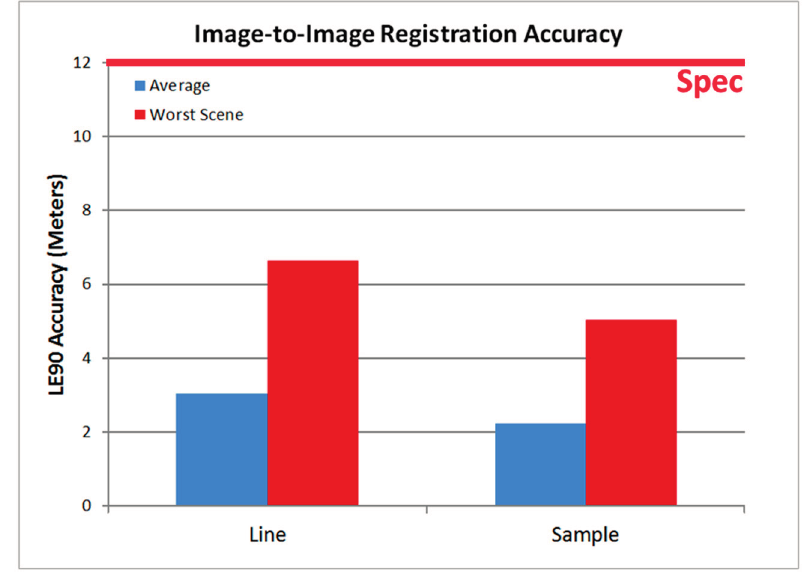
Figure 11. OLI image-to-image registration accuracy; blue bars—average over all test scenes; red bars—worst-case test